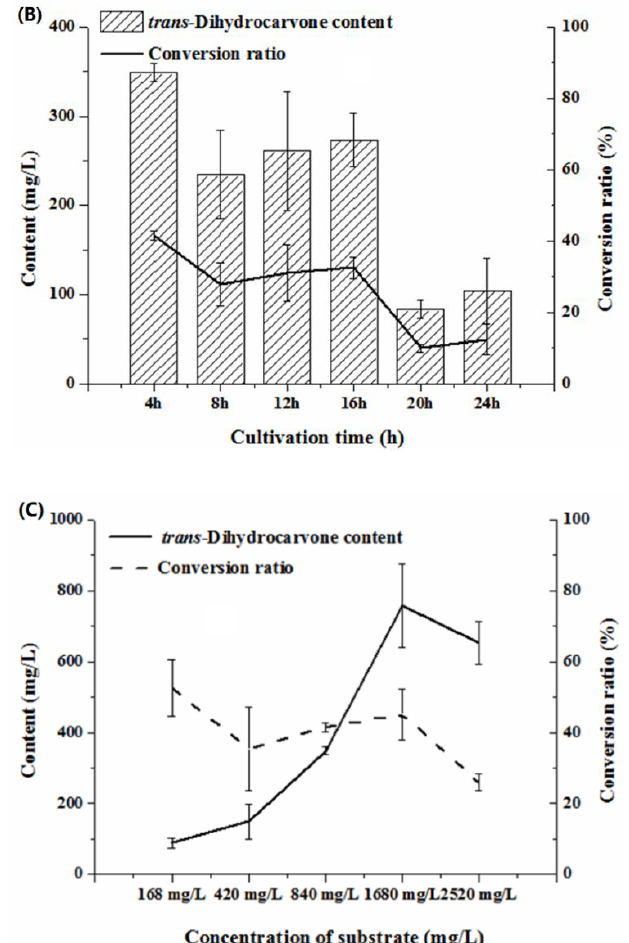
Figure 6. Effect of biotransformation conditions on the production of trans -dihydrocarvone by Klebsiella sp. O852 (cultivation conditions were at 30 °C and 150 rpm). ( A ) Effect of biotransfor- mation time on the production of trans -dihydrocarvone. ( B ) Effect of cultivation time on the pro- duction of trans -dihydrocarvone. ( C ) Effect of substrate concentration on the production of trans - dihydrocarvone.